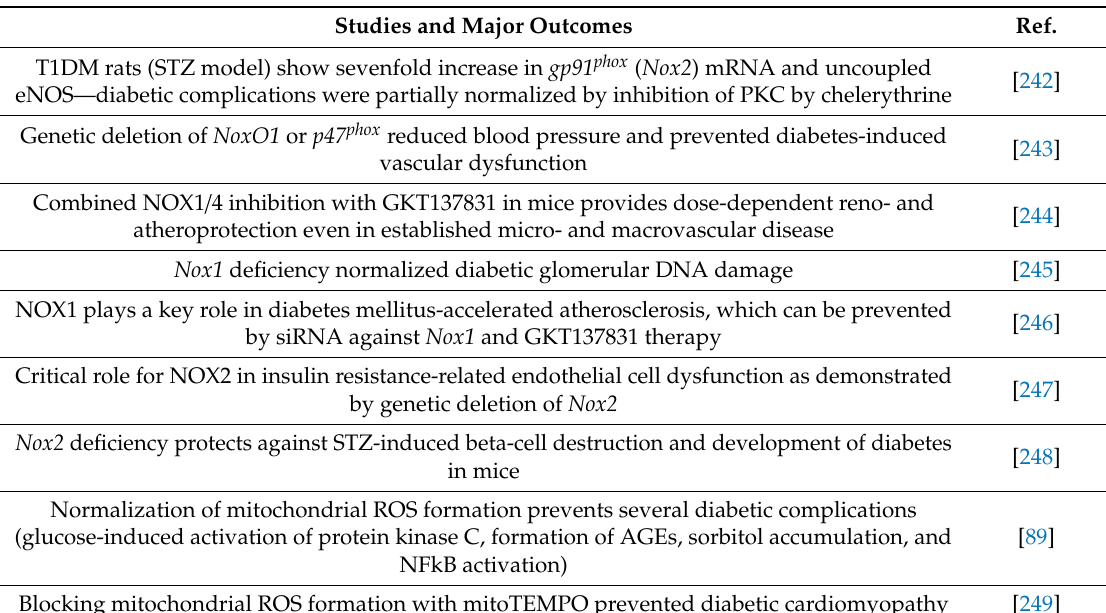
Table 1. Contribution of di ff erent ROS sources to the severity of diabetic complications. Studies and Major